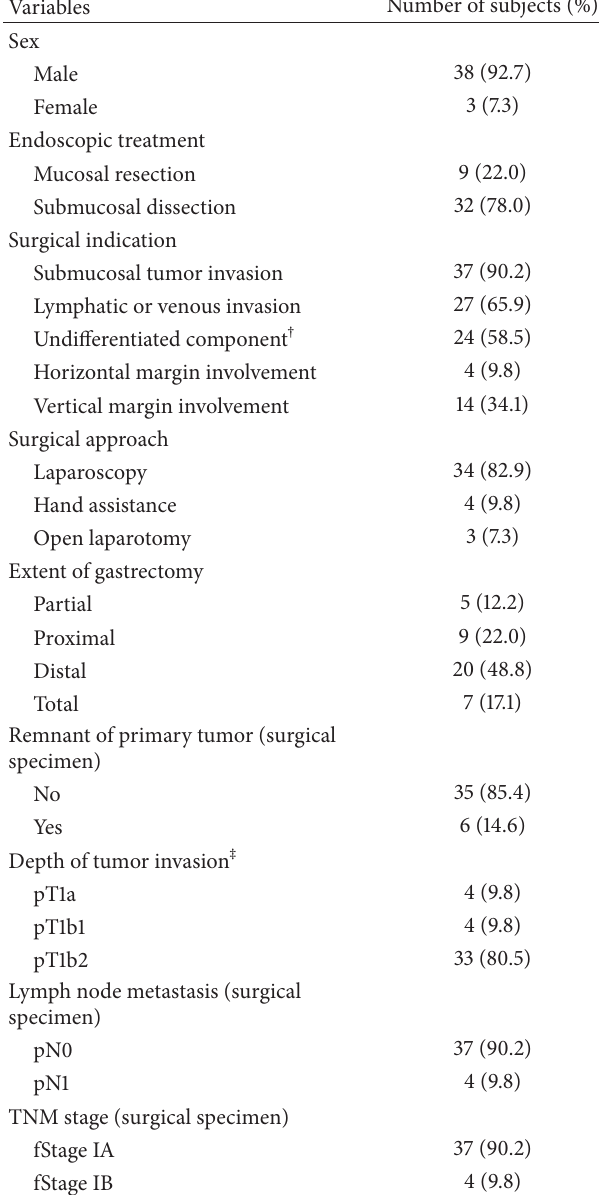
Table 1: Clinicopathological findings of patients ( 𝑛 = 41